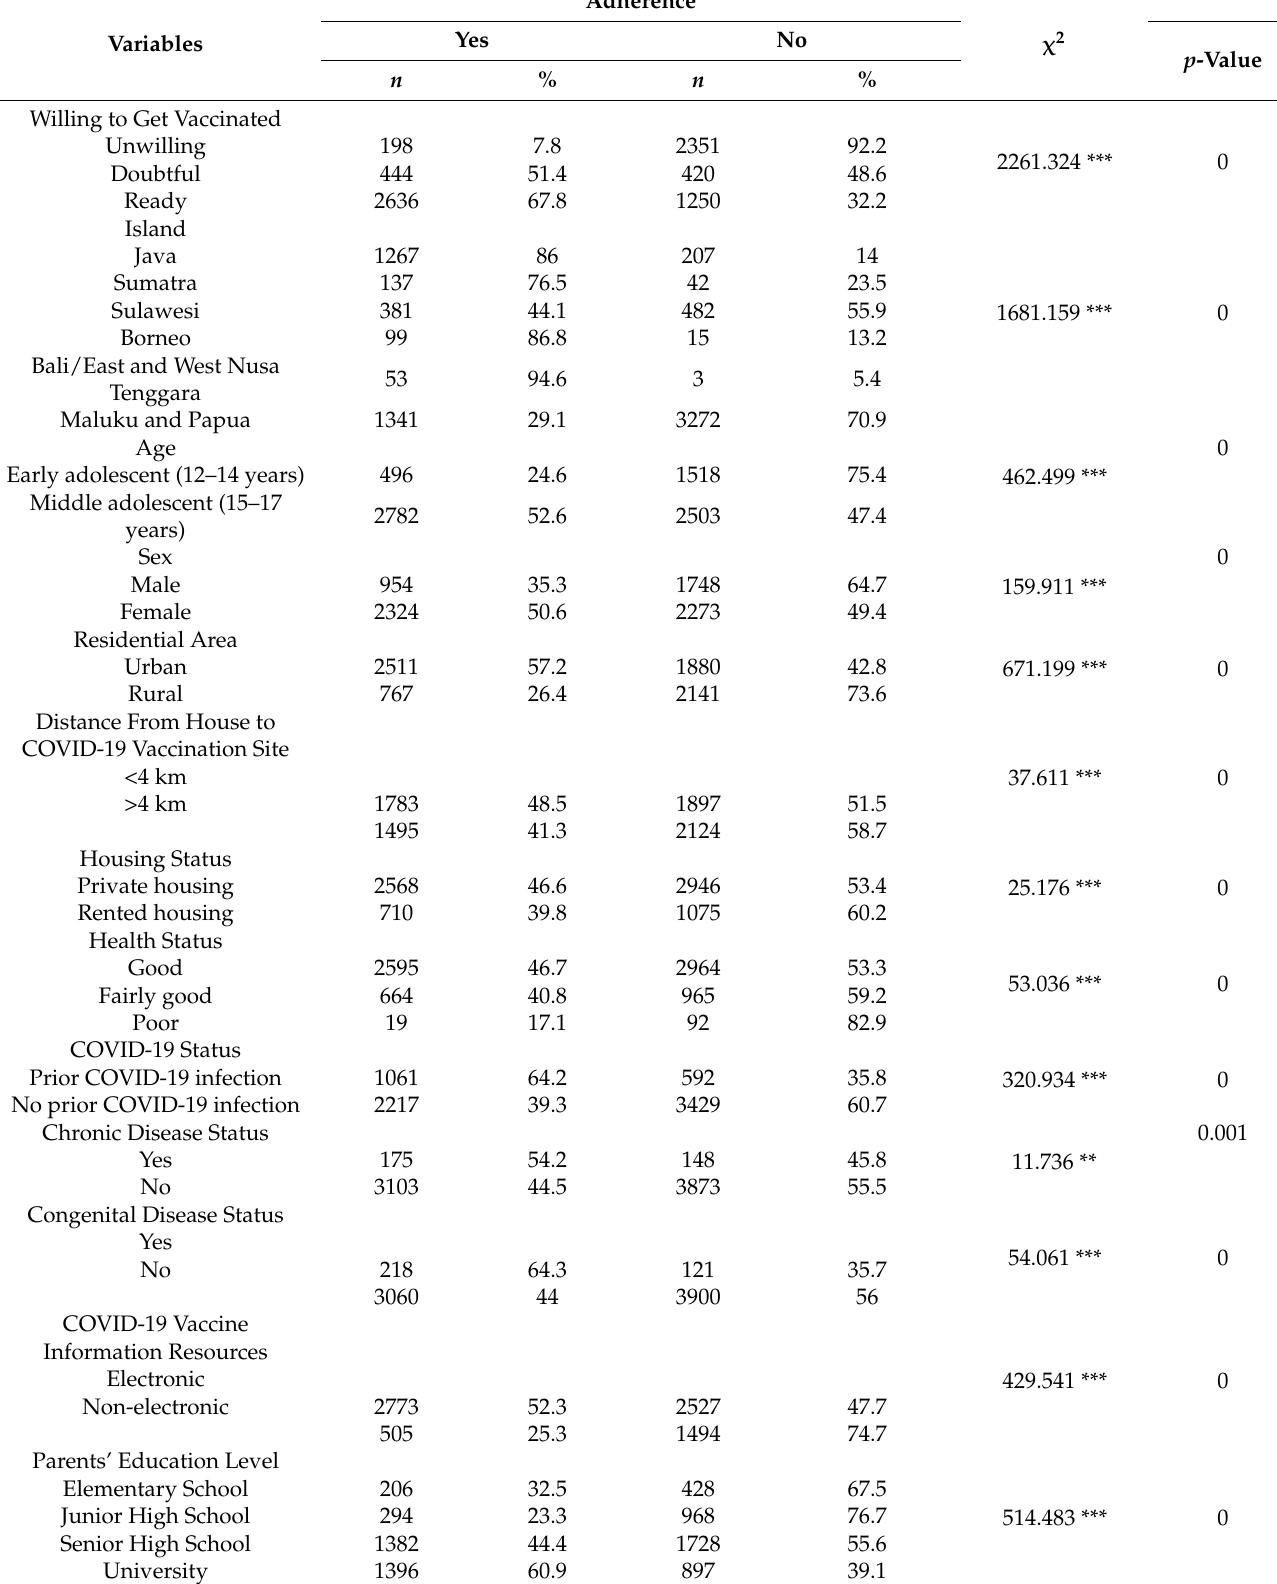
Table 2. Bivariate analysis using chi-square test ( n =